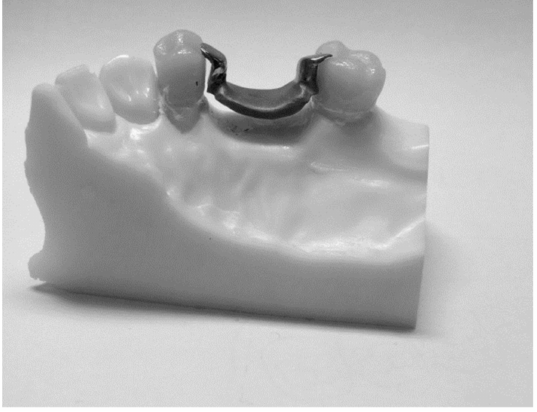
Figure 10. Sample after loading was